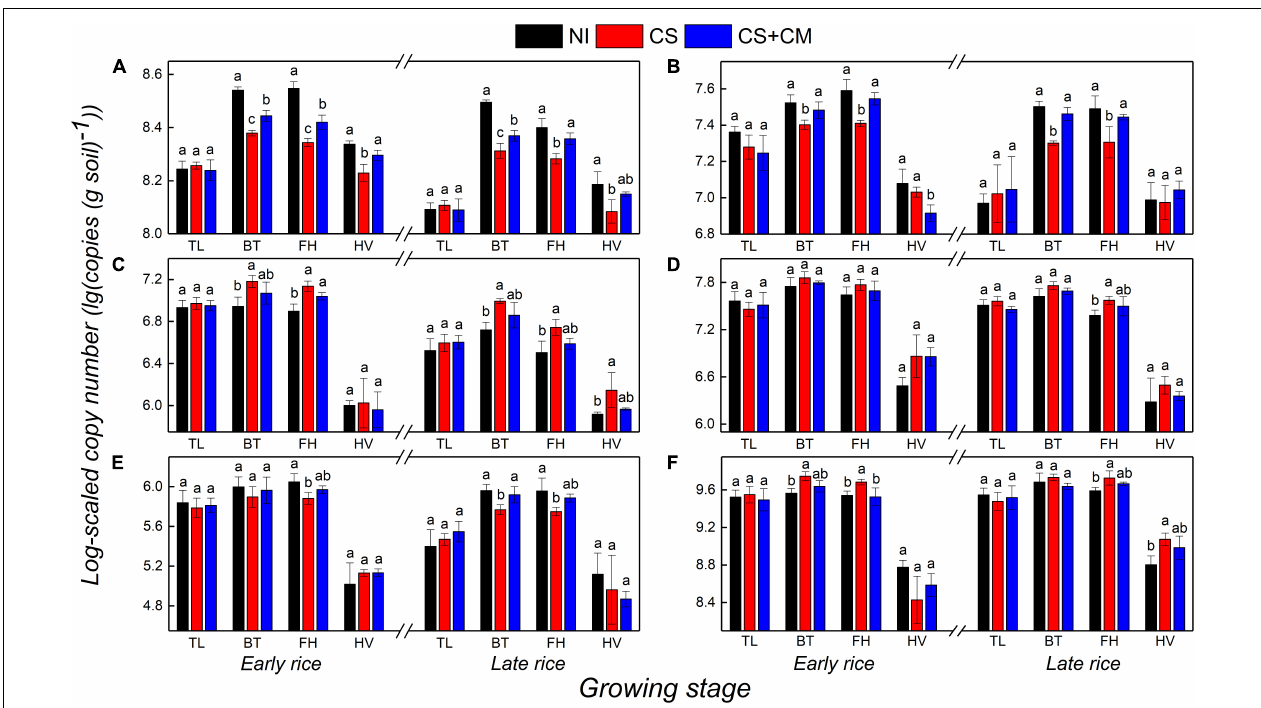
FIGURE 2 | Abundance of AOA-amoA (A) , AOB-amoA (B) , nirS (C) , nirK (D) , pmoA (E) and mcrA (F) genes at log-scale in paddy soil under different treatments at tillering, booting, full heading and harvest stages in pot experiment. NI , no insect; CS , striped rice stem borers; CS + CM , striped rice stem borers + parasitoid wasps. TL, tillering stage; BT, booting stage; FH, full heading stage; HV, harvest stage. The abundance of genes was measured in triplicate per sample. Different letters indicate significant differences at the level of